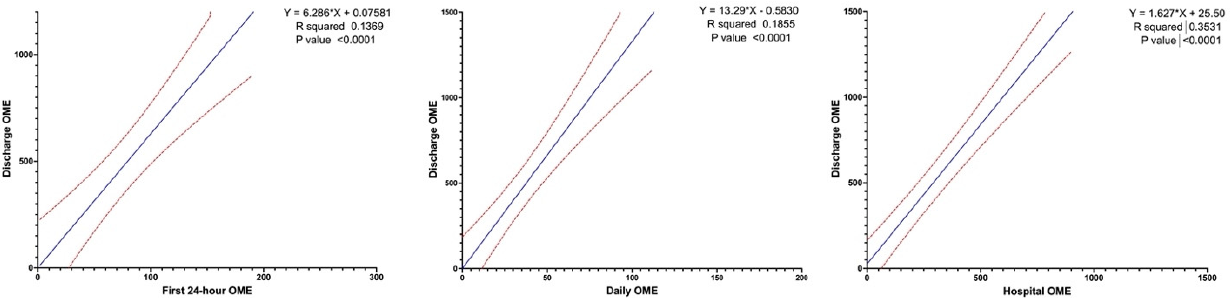
Figure 1. Correlation between first 24-h, Daily, and Total Hospital Oral Morphine Equivalent Use (OME) and Discharge Oral Morphine Equivalent Use. (OME) and Discharge Oral Morphine Equivalent